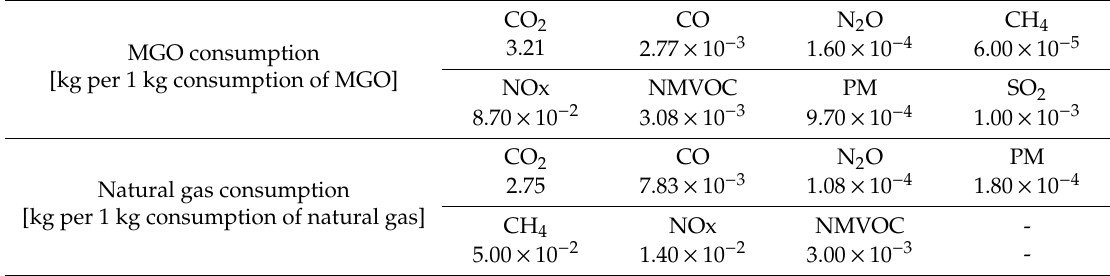
Table A9. Emission factors of MGO and natural gas at the Tank-to-Wake